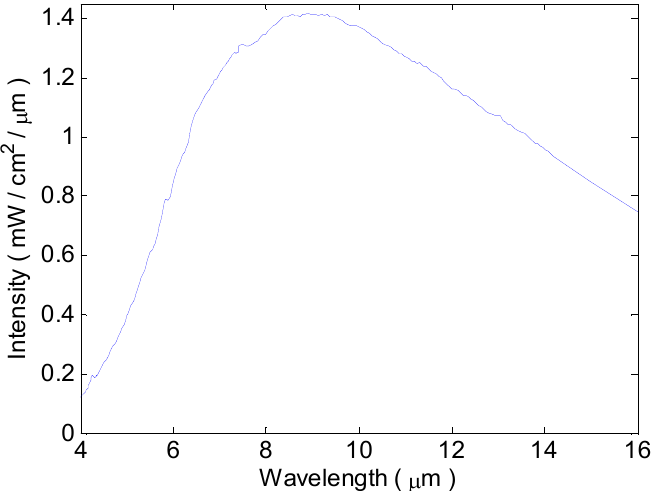
Figure 5. The spectrum of FIR ceramics at 50 °C. The total intensity of the wavelengths between 4 µm and 16 µm is 12.37 mW/cm 2 .